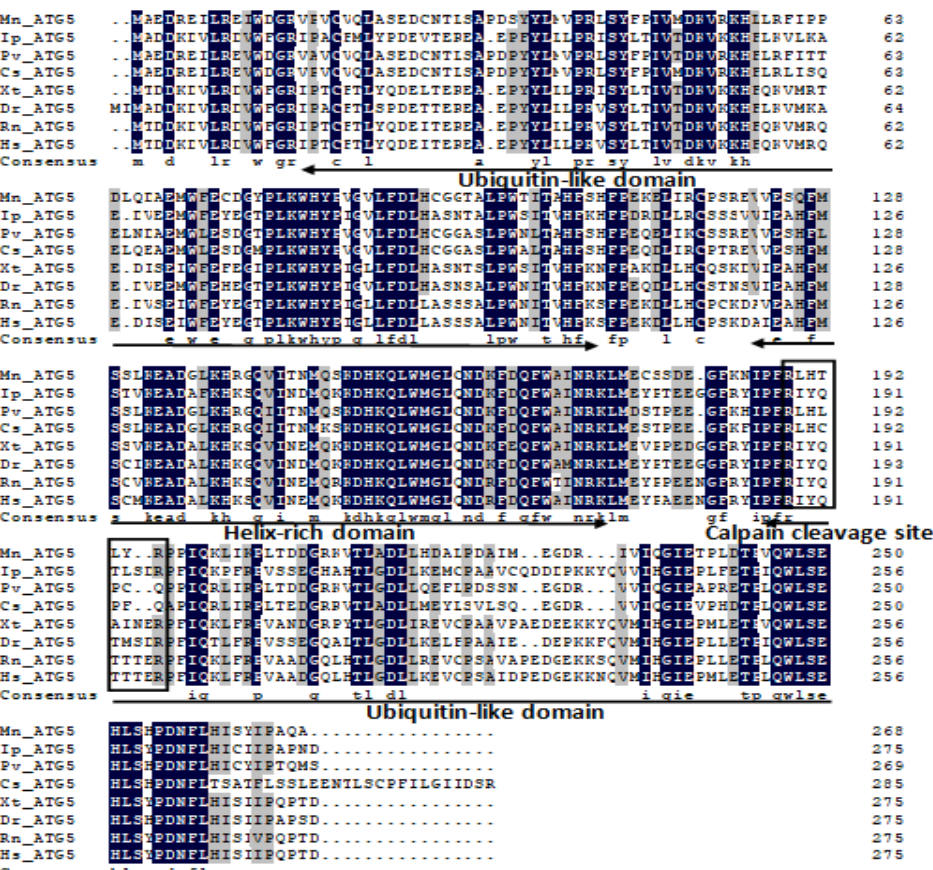
Figure A3. Multiple amino acid sequence alignment of ATG5 from Macrobrachium nipponensis and other species. The accession numbers for ATG5 from Macrobrachium nipponensis (Mn), Ictalurus punctatus (Ip), Penaeus vannamei (Pv), Callinectes sapidus (Cs), Xenopus tropicalis (Xt), Danio rerio (Dr), Rattus norvegicus (Rn) and Homo sapiens (Hs) are MK296401, AHH42402.1, ROT80704.1, CAJ31266.1, XP_012818455.1, NP_991181.2, CAJ31281.1, and AGC52703.1 respectively. The arrows below the sequences indicate the conserved domain (two ubiquitin-like domains and a helix-rich domain). The conserved calpain cleavage sites are boxed.